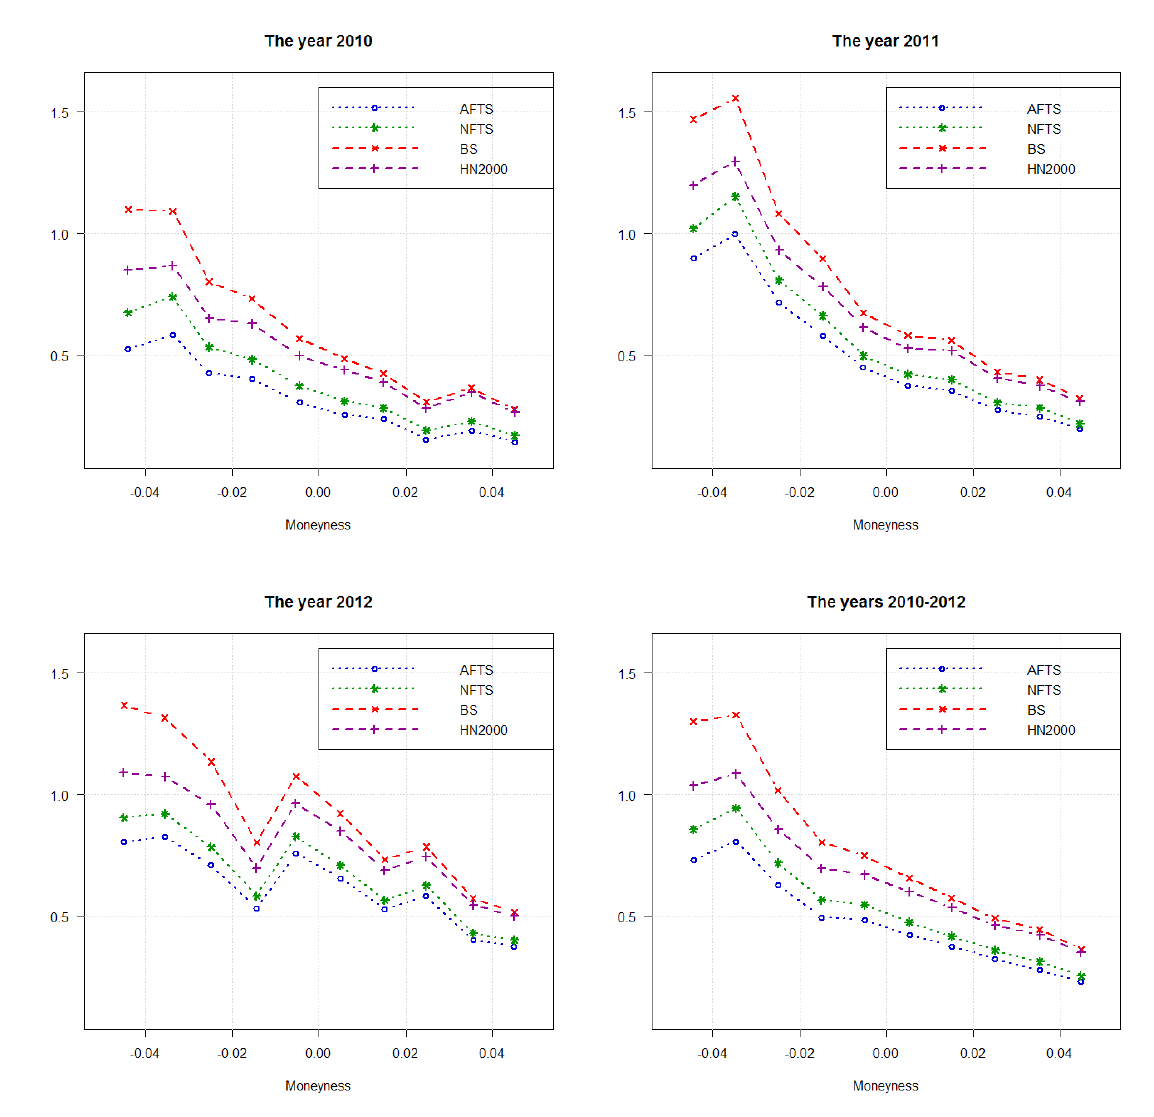
Figure 4. In-sample average absolute errors as a function of moneyness